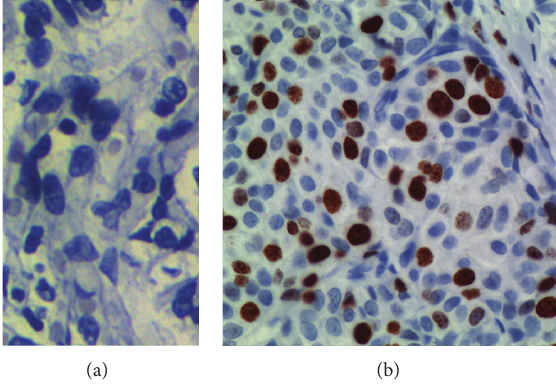
Figure1:p53immunohistochemicalstaininginnormalbreasttissue and breast cancer. (a) No p53 immunoreactivity was observed in the normal breast cells. (b) A mutant case with strongly posi- tive nuclear staining. Positive p53 immunoreaction in the tumor area is indicated by brown color. Negative nuclei show only the counterstain, indicated by the blue color. Immunostaining was performed with the mouse anti-human p53 monoclonal antibody DO-7. (Immunoperoxidase staining with nuclear counterstain with hematoxylin. Magnification: × 63.)